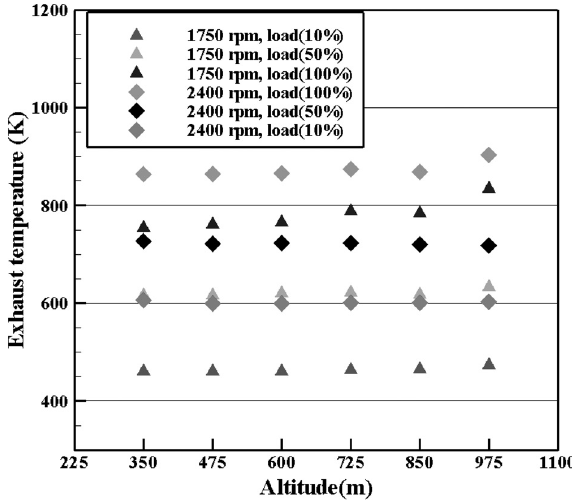
Fig. 5. Effect of altitude on exhaust